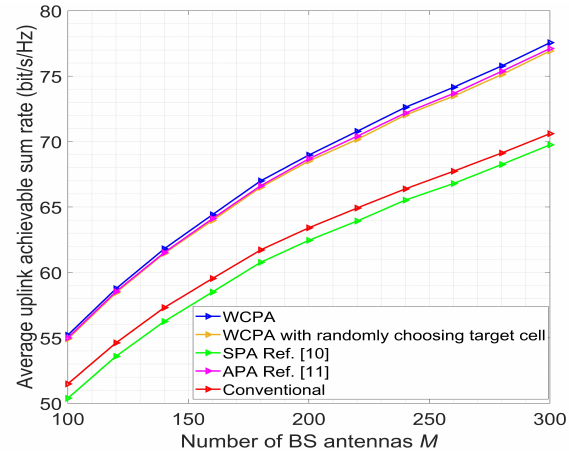
Figure 5. CDF of uplink achievable sum rate in case K = 8, S = 12.